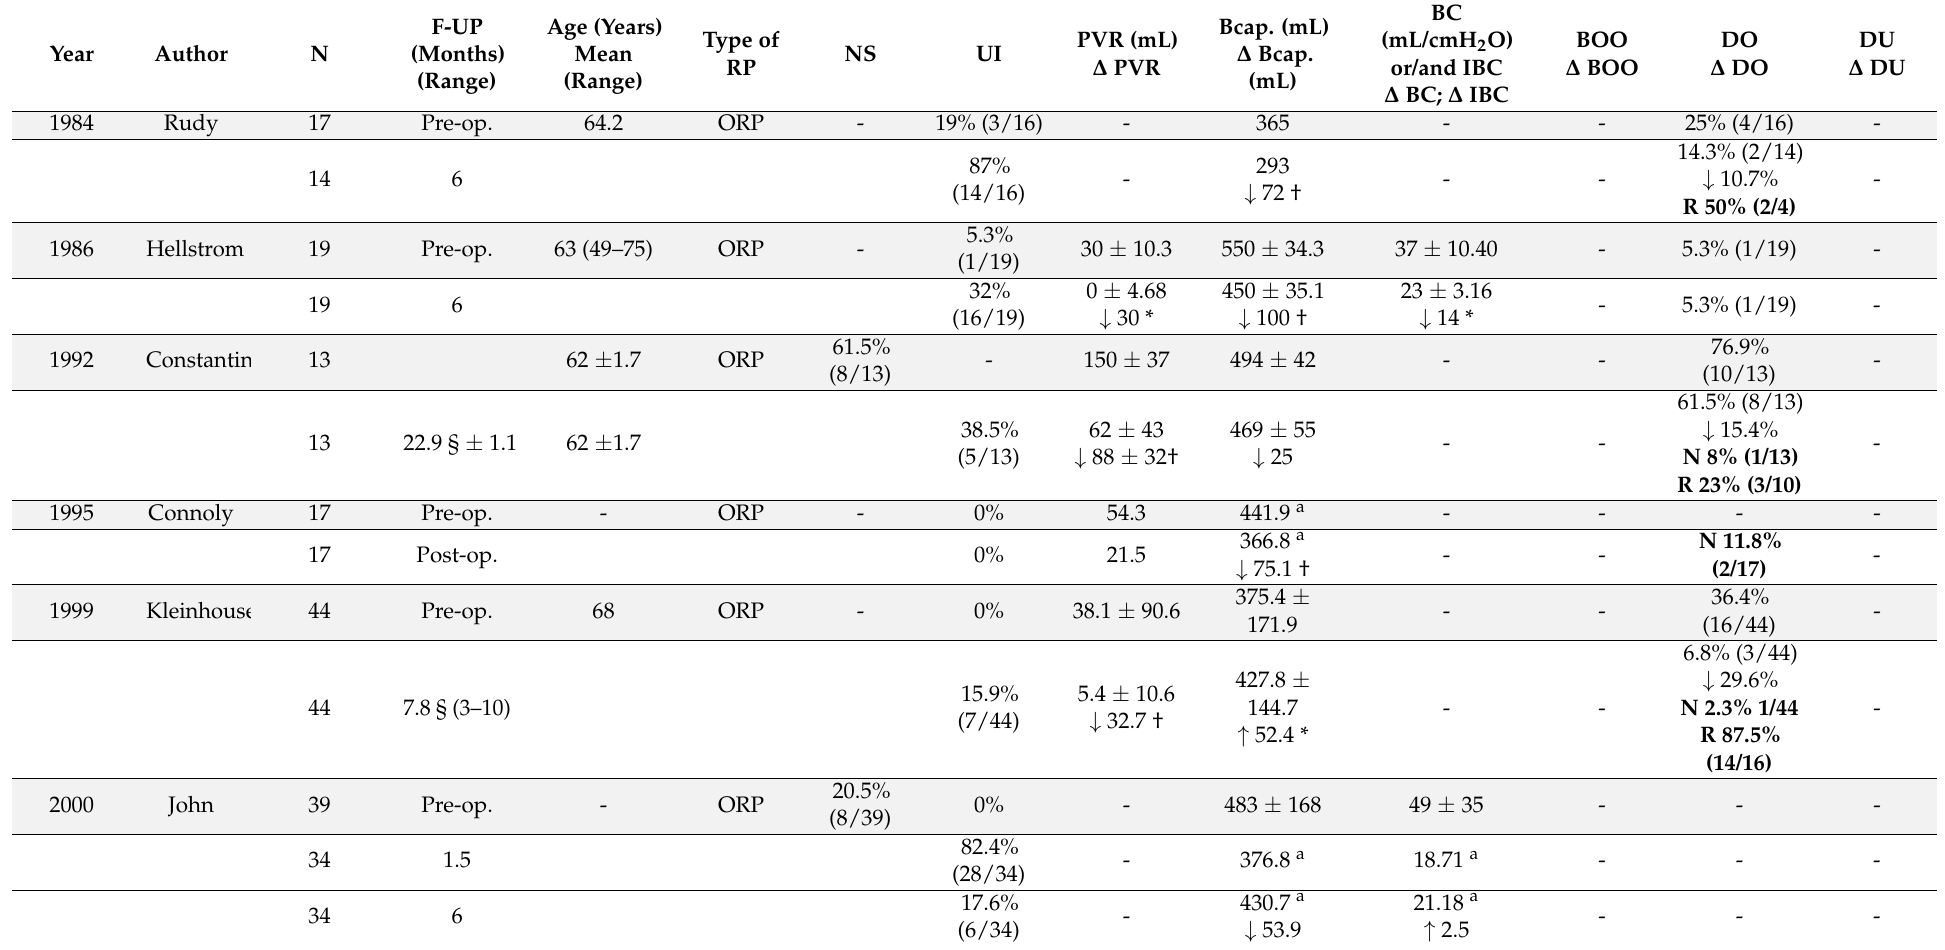
Table 2. Qualitative synthesis of data from included